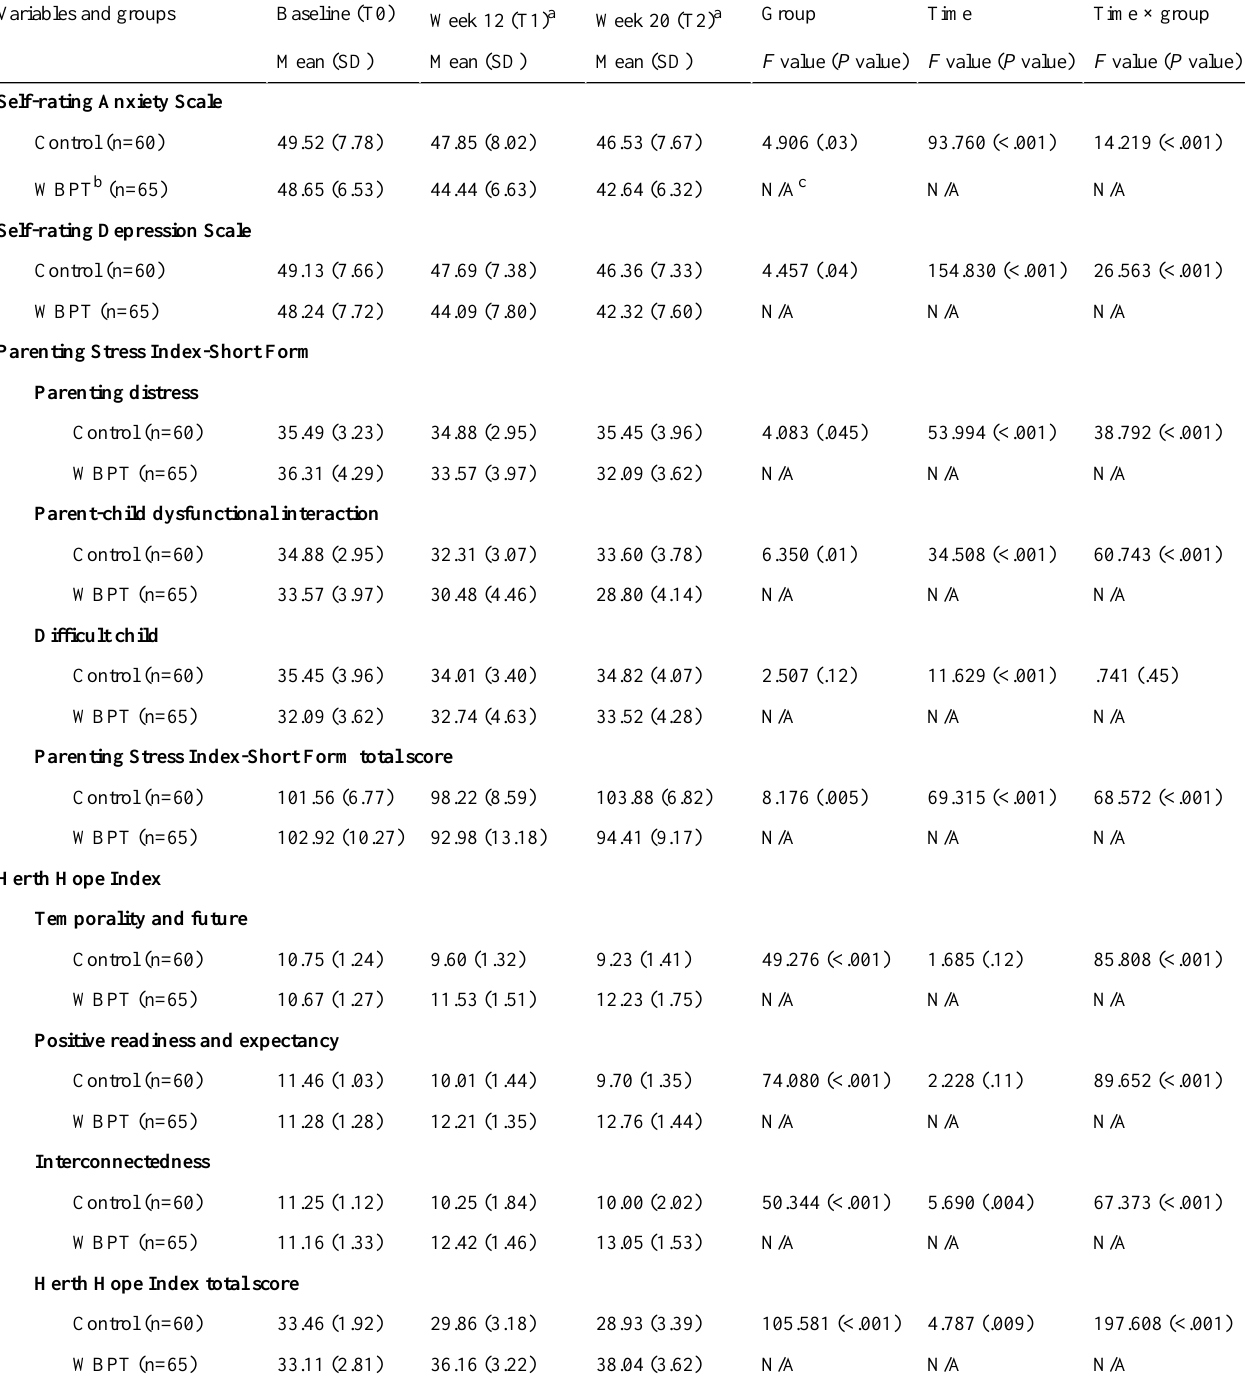
Table 2. Comparisons of scores between groups over time using a linear mixed model